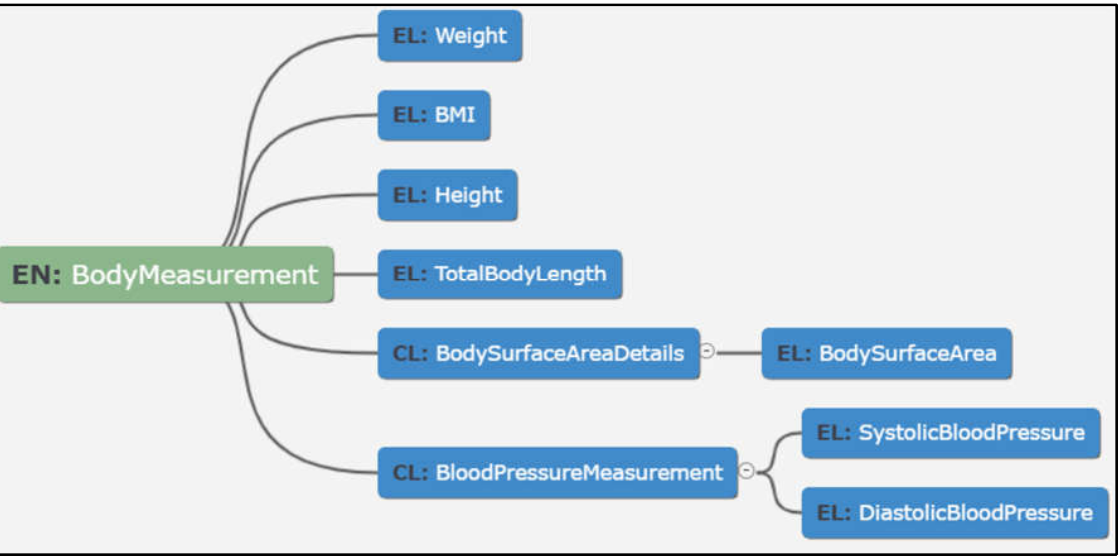
Figure 8. Image of the mind map of a modelled data dictionary. EN—entry; CL—cluster; EL—element.